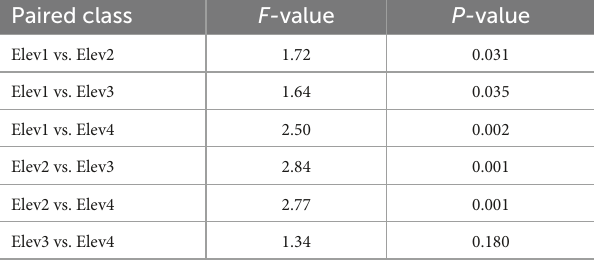
TABLE 3 Pairwise nematode compositional dissimilarity between the studied elevational classes using Bray–Curtis dissimilarity metric. Paired class F- value P- value